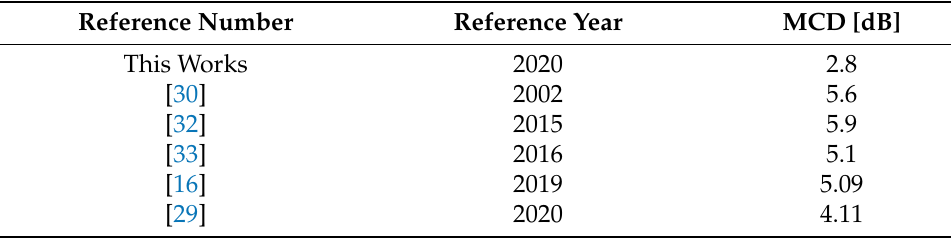
Table 3. Comparative MCDs from previous